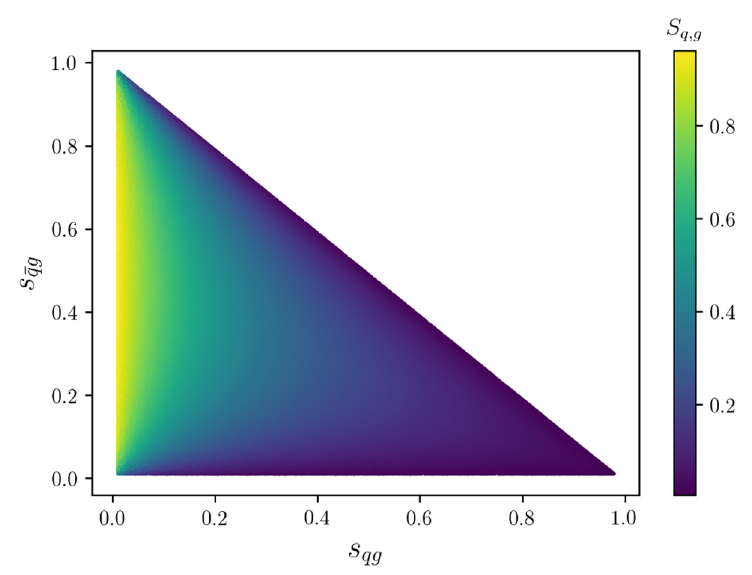
Figure 2 . Behaviour of the S q;g FKS partition